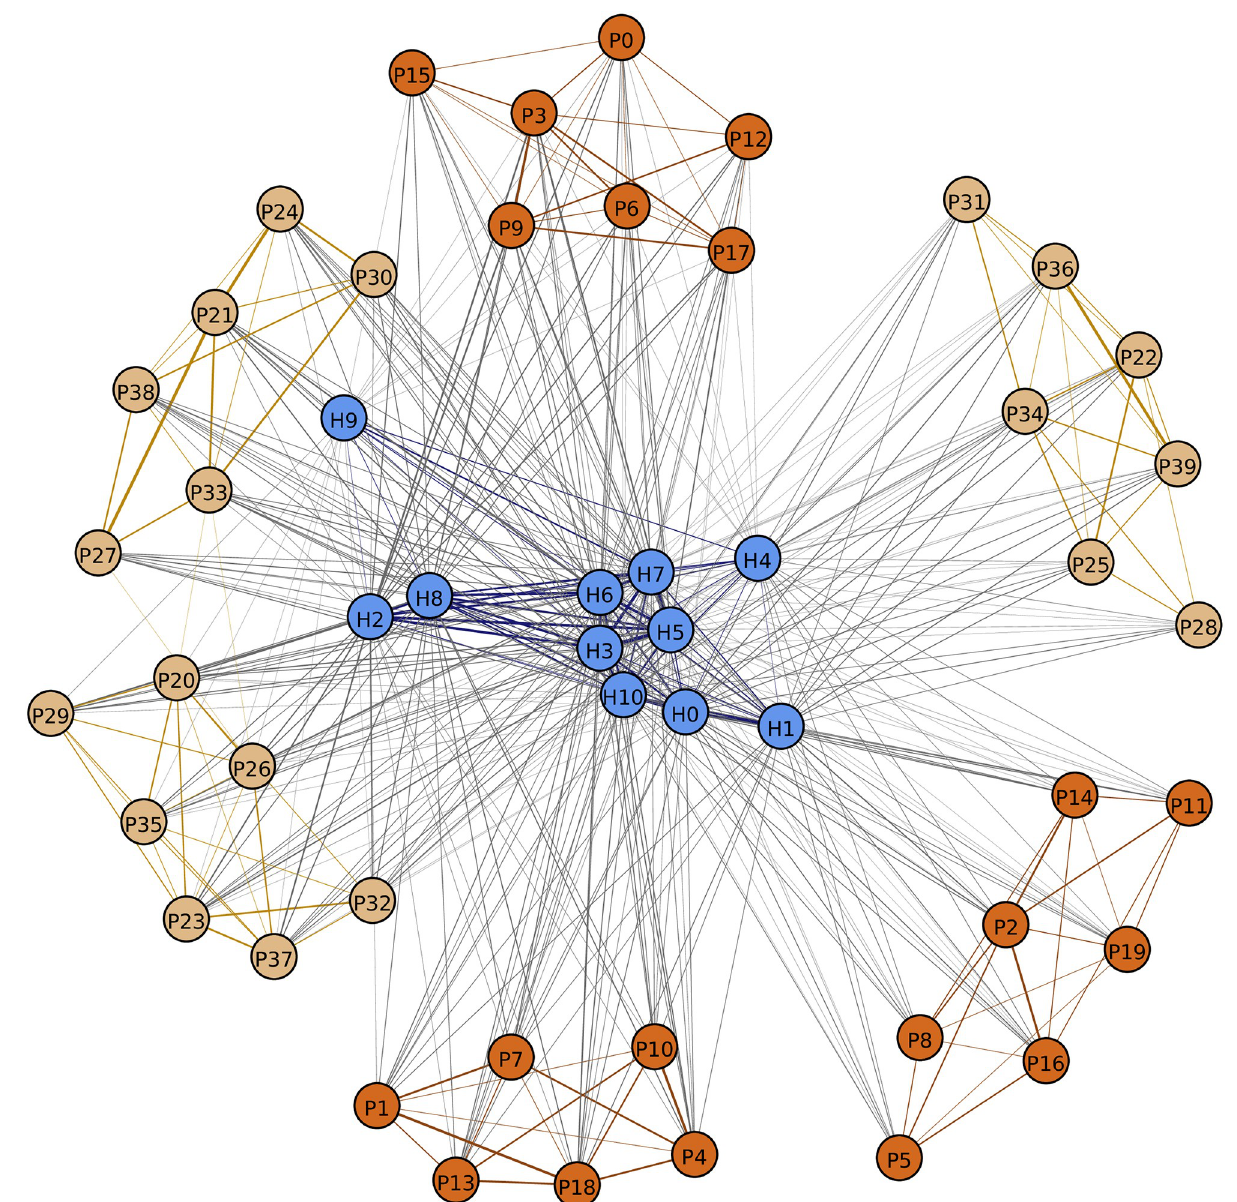
Fig 3. Contact network G . HCP nodes, MWF patient nodes, and TThS patient nodes are depicted in blue, chocolate, and burlywood colors, respectively. Contacts within the same type of nodes are represented as edges colored according to node type. Grey colored edges represent HCP- patient contacts. The thickness of the edge corresponds to the contact duration. Patients mostly have contact with other patients at the same dialysis session unless there is an overlap between sessions, hence we observe 6 patient clusters (3 sessions per day on MWF and TThS) of 6 or 7 patients each. For any session, a patient will be in contact with at most 2 neighboring patients, thanks to how neighboring dialysis chairs are positioned. Over several sessions, depending on which chair they occupy, a patient may come in contact with several other